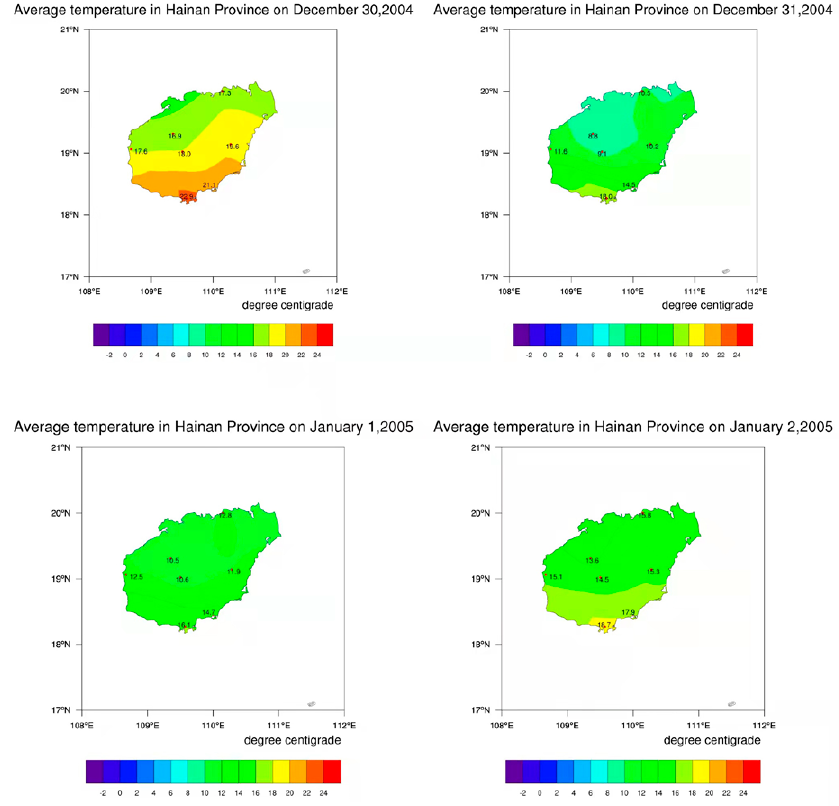
Figure 7. Daily temperature distributions for Hainan between 30 December 2004 and 2 January 2005 (°C)